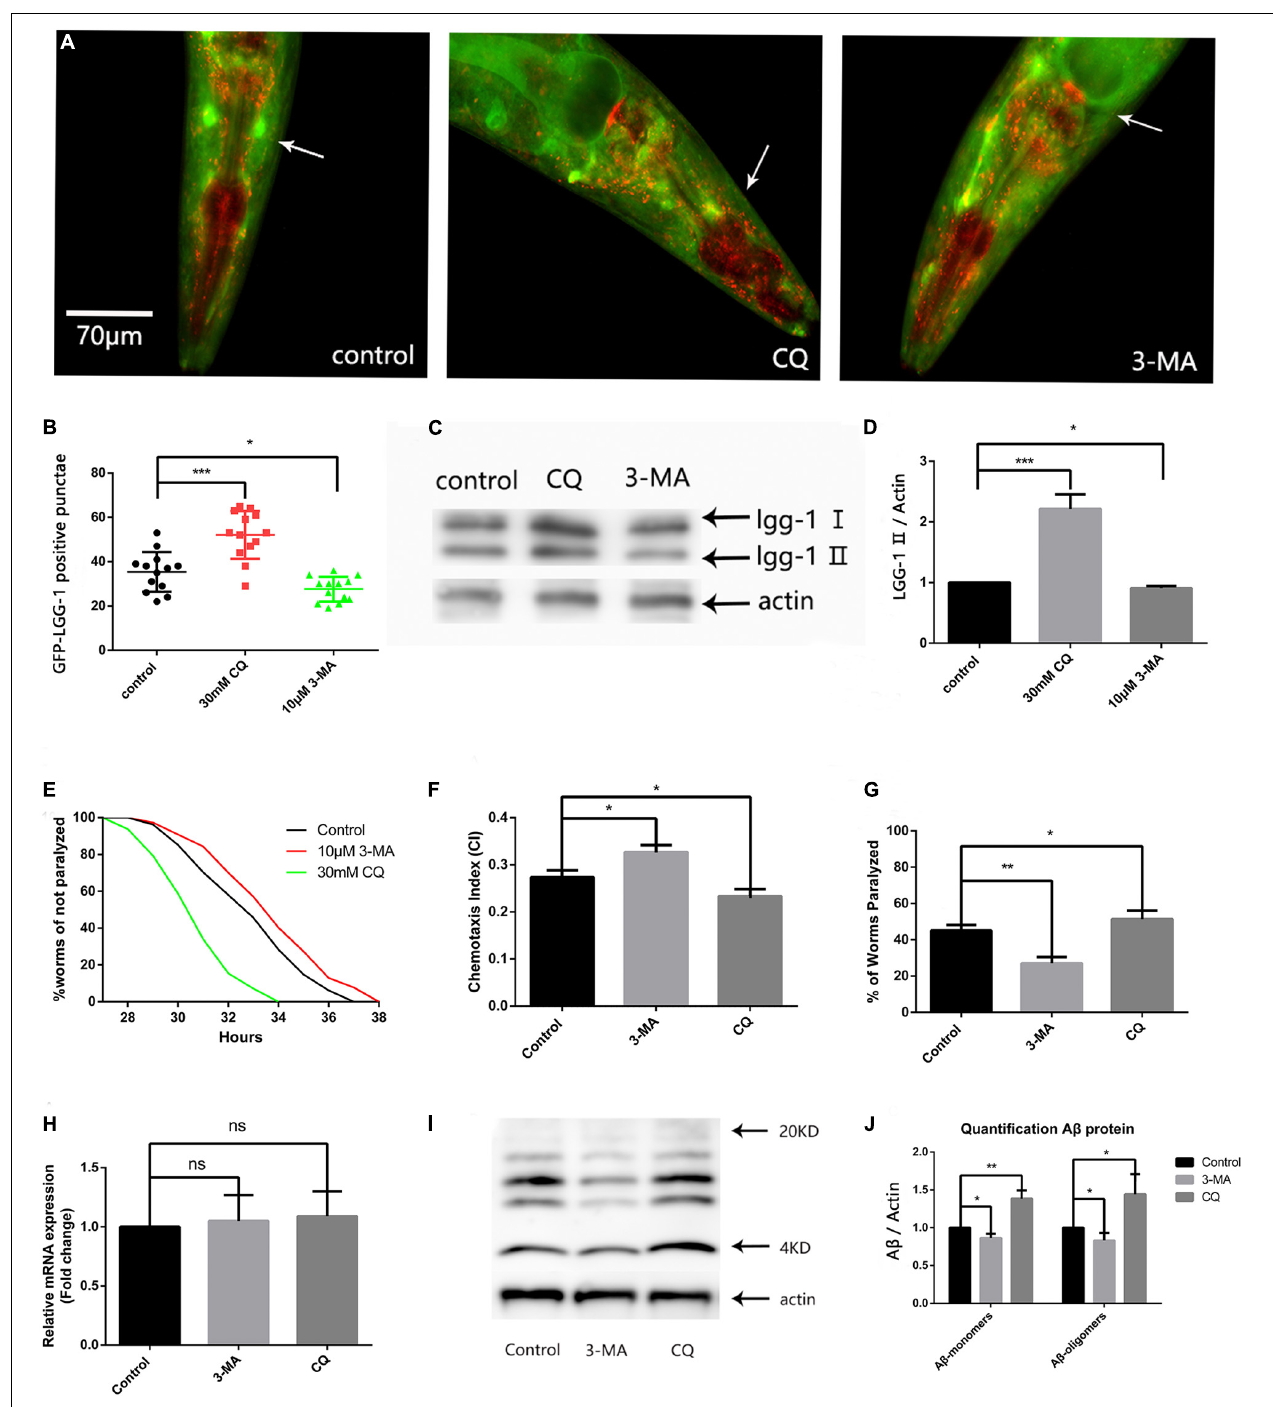
FIGURE 3 | Reducing autophagosome accumulation delays A β -induced paralysis in the CL4176 strain and suppresses neuronal A β expression-induced defects in chemotaxis behavior and 5-HT sensitivity. (A) Punctae formation in the GMC101 strain as shown by fluorescence microscopy. (B) Scoring of punctae ( n = 13 per group, * p < 0.05; *** p < 0.001 by the Student’s t -test). (C) Representative western blot of mCherry::GFP::lgg-1. (D) Quantified western blot gel intensities, as determined by ImageJ software ( n = 3, * p < 0.05; *** p < 0.001 by the Student’s t -test). (E) 3-MA delayed A β -induced paralysis and CQ accelerated A β -induced paralysis in the CL4176 strain ( n = 3, ** p < 0.01; *** p < 0.001 by the log-rank test). (F) 3-MA significantly improved chemotaxis while CQ significantly impaired chemotaxis. (G) Serotonin hypersensitivity was restored to normal levels by 3-MA. CQ worsened serotonin hypersensitivity. Each group contained about 60 worms ( n = 3, * p < 0.05; ** p < 0.01). (H) A β mRNA expression in treated and untreated nematodes. (I) Representative western blot of A β species in transgenic nematodes. (J) Quantified western blot gel intensities, as determined by ImageJ software ( n = 3, * p < 0.05; ** p < 0.01 by the Student’s t